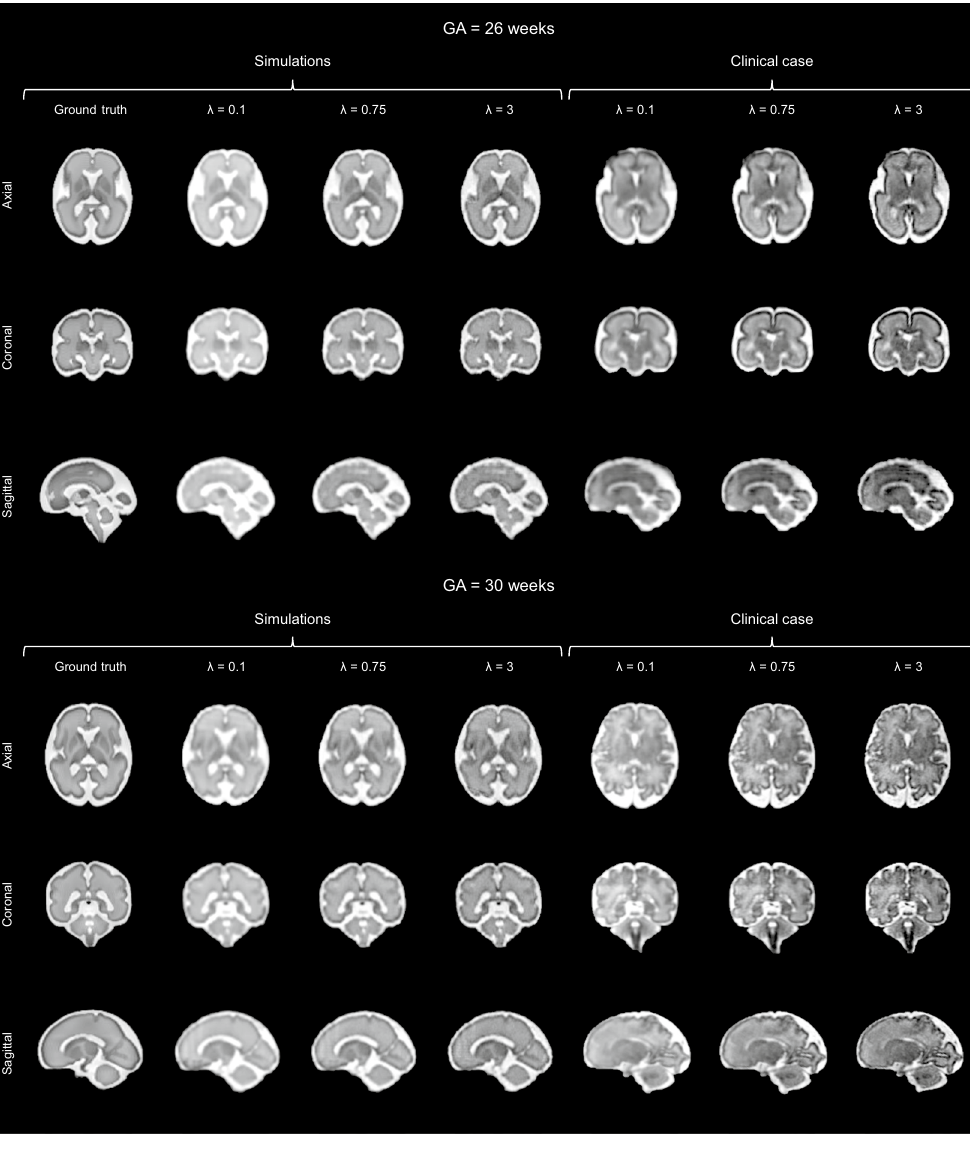
Figure 3. Appreciation of the quality of SR reconstruction depending on the weight (cid:31) that controls the strength of the TV regularization. The potential of our framework FaBiAN for optimizing the reconstruction quality through parameter fine-tuning in the presence of motion is illustrated at two GA: 26 and 30 weeks. Two representative clinical cases are provided for comparison. The results for three values of (cid:31) are presented. For (cid:31) = 0.1 , the SR reconstruction looks blurry with poor tissue contrast. Using (cid:31) = 3 improves the contrast but the images look noisy. For (cid:31) = 0.75 , the SR reconstruction is sharp with a contrast between different brain tissues similar to that observed in the 3D isotropic ground truth. Clinical cases from which the simulated HASTE images are derived highlight the accuracy of a SR reconstruction for this intermediate value of (cid:31) , especially with regards to the definition of the corpus callosum and the delineation of the